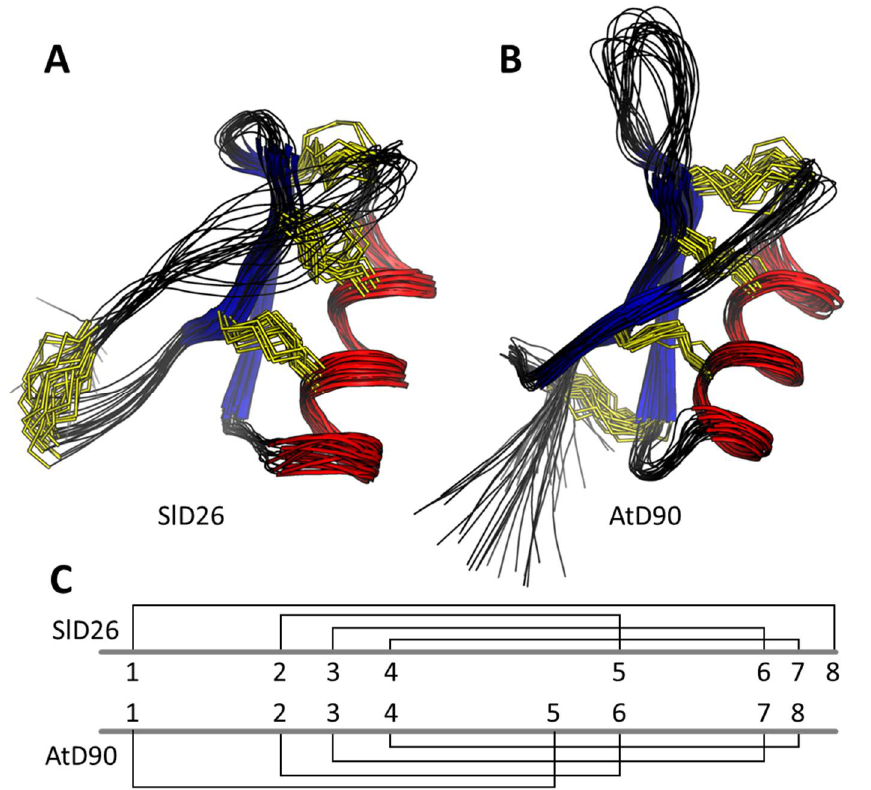
Figure 3. Structural analysis of histidine-rich defensins. Overlay of the 20 lowest-energy states for ( A ) SlD26 and ( B ) AtD90 with disulfides in yellow, beta strands in blue, and alpha helices in red. The differences in disulfide connectivity when comparing SlD26 and AtD90 are shown in panel ( C ). Numbers indicate the order of cysteine residues in the defensin amino acid sequence.